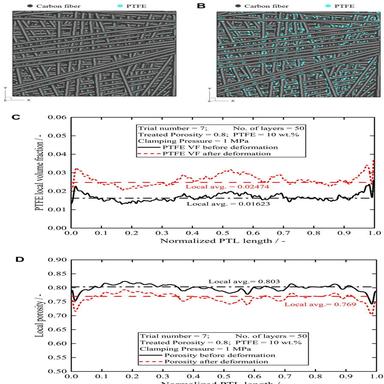
Top-view PTFE distributions (green) (a) before and (b) after the external stack compression, and quantitative variations of local PTFE and void volume fractions along the normalized PTLs thickness (c) before and (d) after the external stack compression.